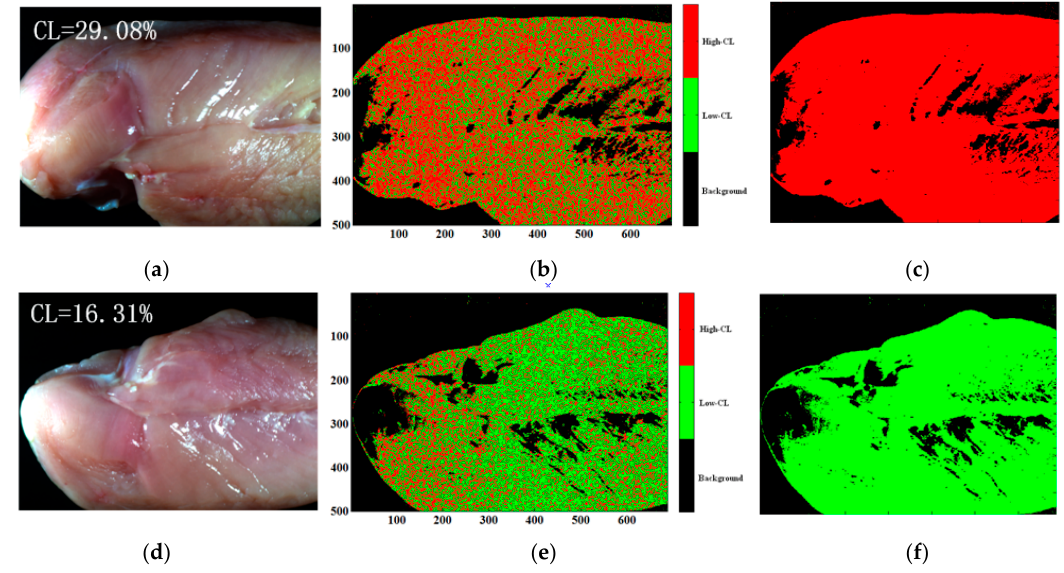
Figure 8. Classification maps of CL categories at the pixel and fillet level. ( a , d ) Fillet pseudo-color images; ( b , e ) Pixel-level classification maps; ( c , f ) Fillet-level classification maps.